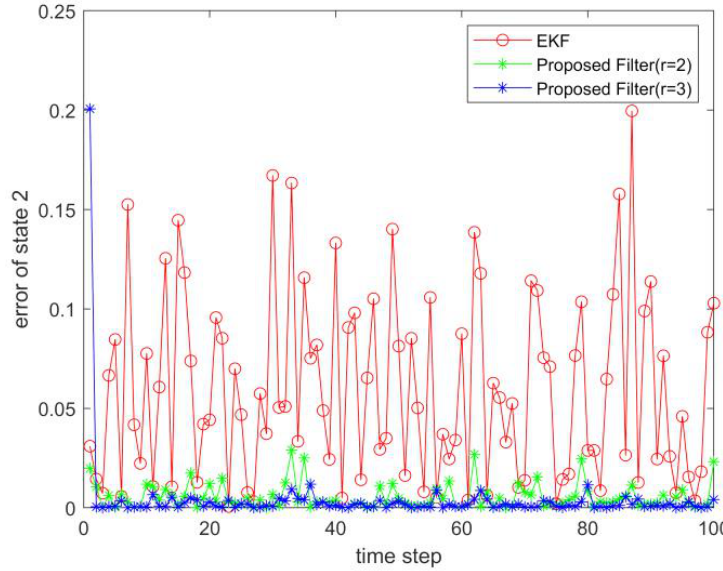
Figure 7. Estimation error of state 1.